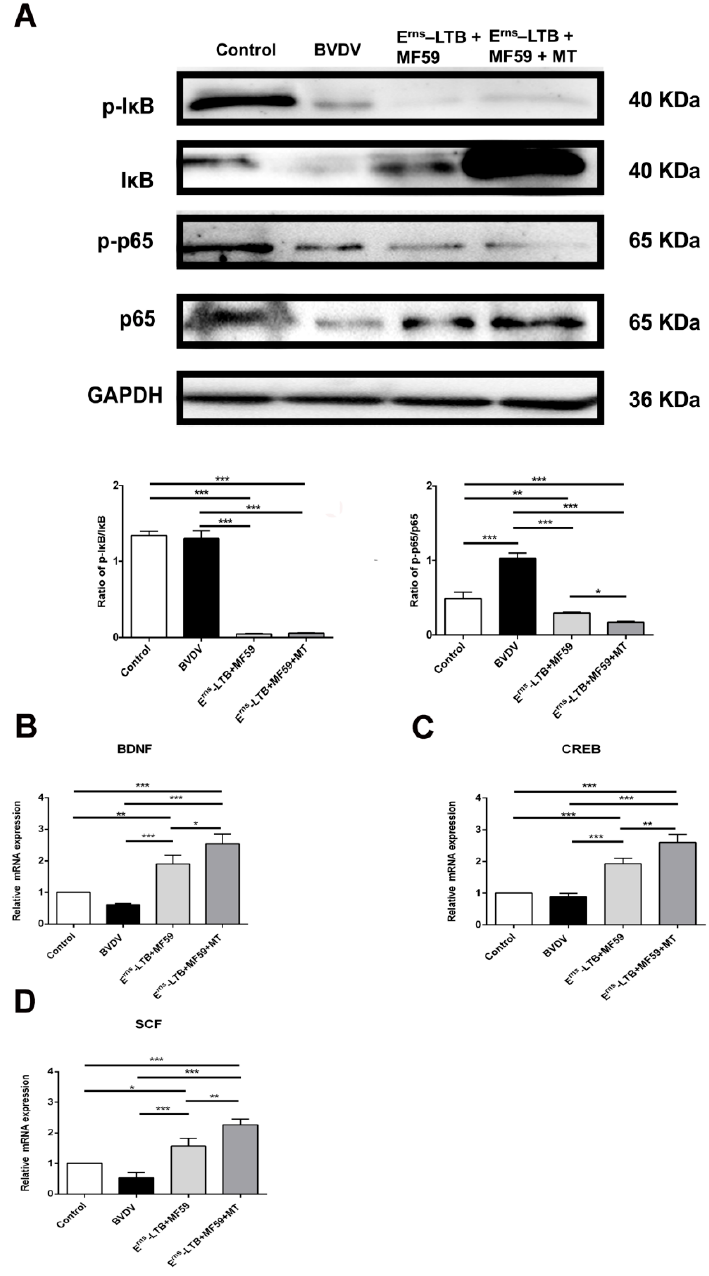
Figure 6. Comparison of the NF- κ B related protein expressions, and mRNA levels of memory-related proteins in vivo. ( A ) Relative protein expression levels were based on western blot band intensity; protein levels were normalized with I κ B and p65, respectively. Representative western blot image of p-I κ B, I κ B, NF- κ B p-p65, p-65 expression levels in the hippocampus. ( B ) mRNA expression of BDNF; ( C ) mRNA expression of CREB; ( D ) mRNA expression of SCF. The values in each column represent the mean ± SEM of three individual mice from each group detected in triplicate. * p < 0.05; ** p < 0.01; *** p < 0.001.